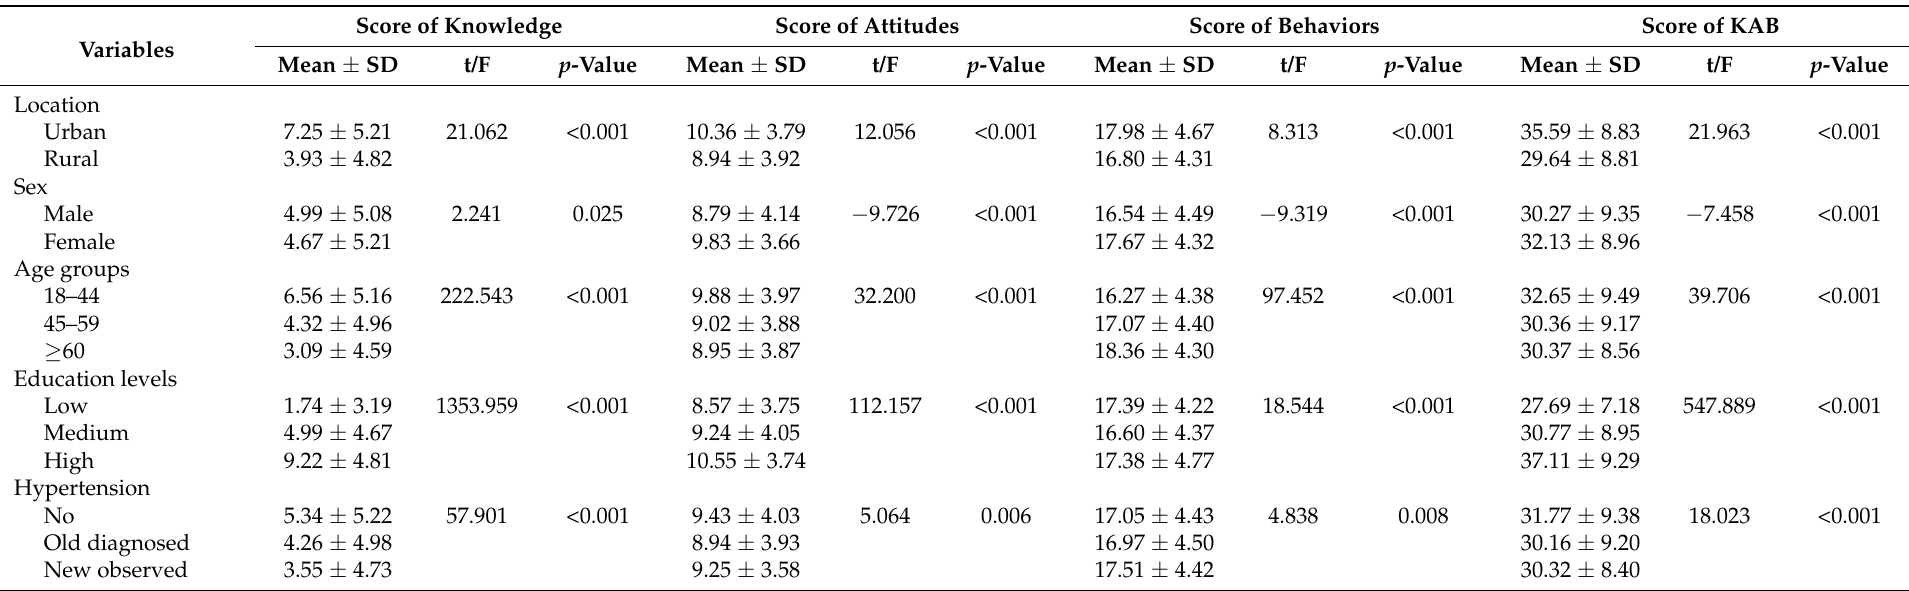
Table 3. Knowledge, attitude, behavior, and KAB scores of participants with different sociodemographic